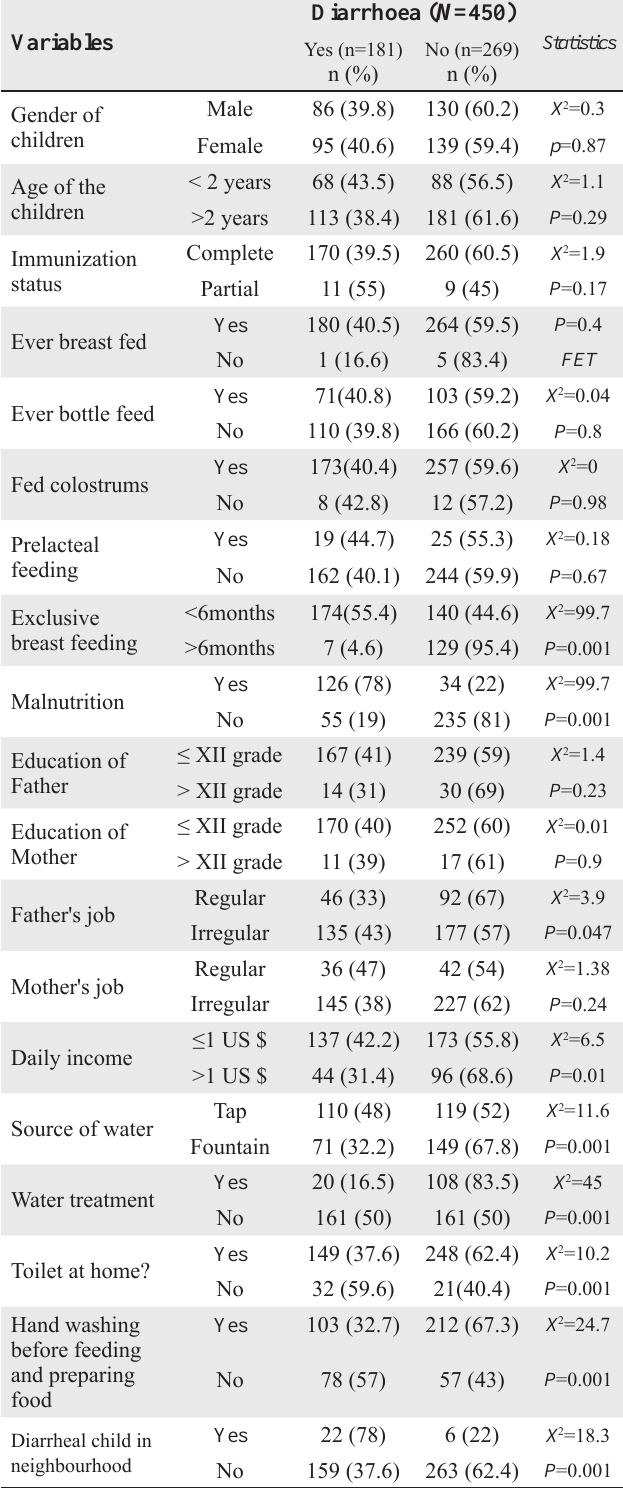
Table: 1 Demographic characteristics of the independent variables